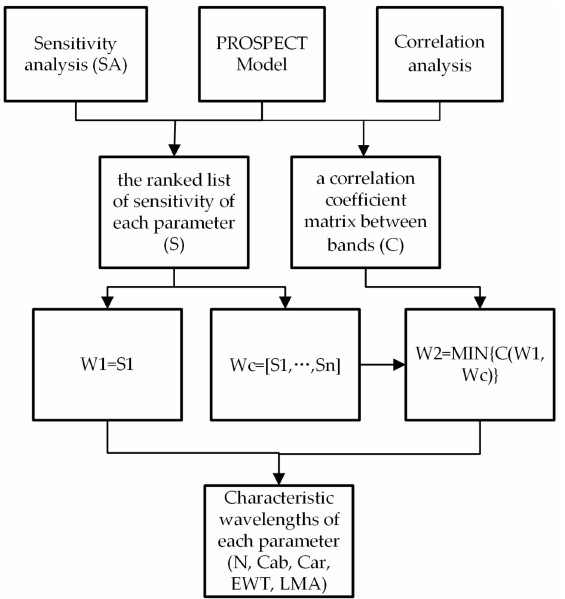
Figure 1. The workflow chart of the characteristic wavelengths selection algorithm. Step (1) A ranking list of contribution rates/sensitivities (S) of PROSPECT5 input parameters (N, Cab, Car, EWT, and LMA) to leaf reflectance over the 400–2500 nm spectral range was obtained by SA, and a correlation coefficient matrix (C) between bands over the 400–2500 nm spectral range was obtained by correlation analysis (Figure